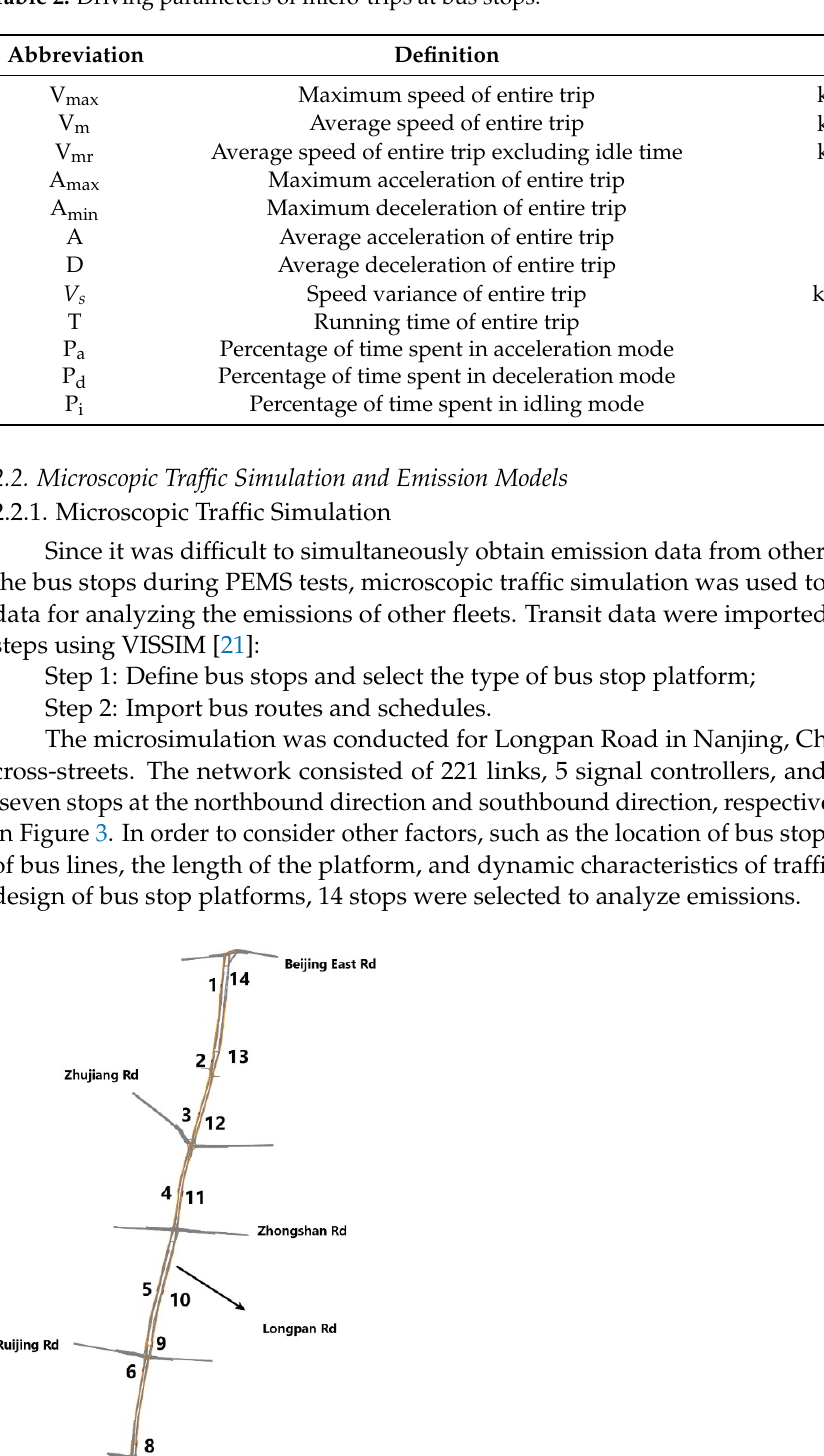
Table 2. Driving parameters of micro-trips at bus stops.